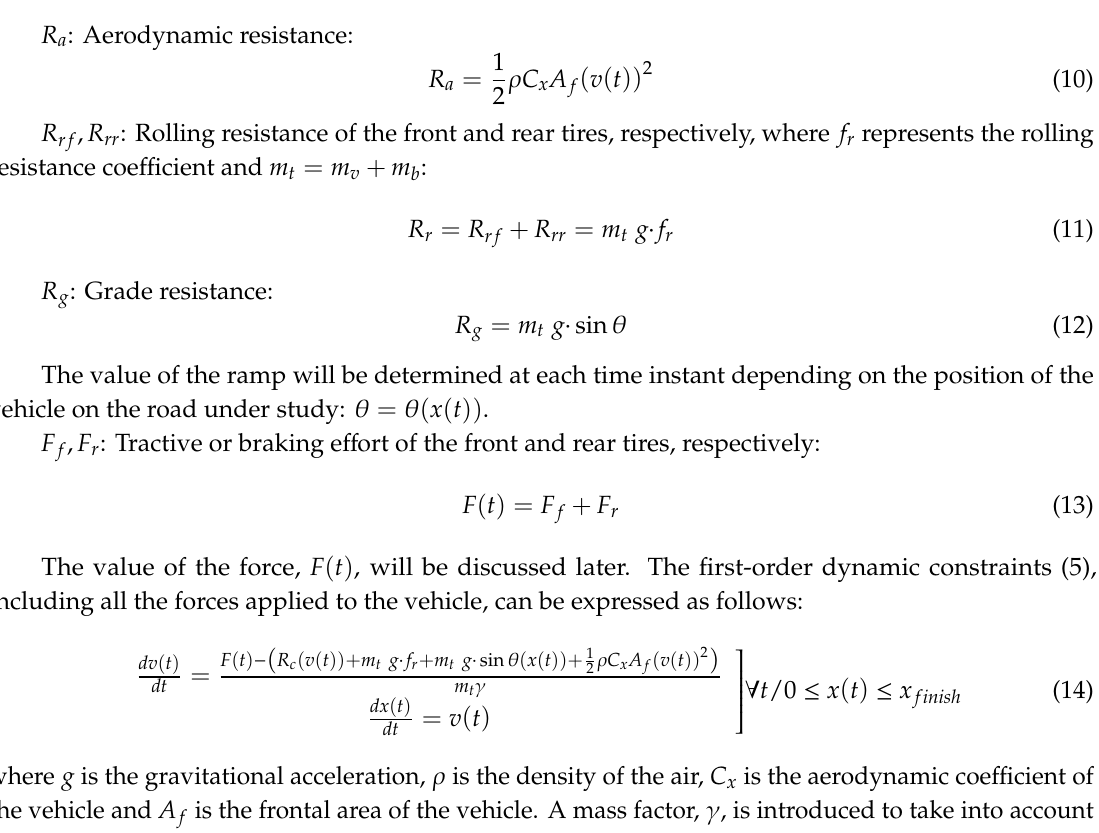
Figure 2. Forces acting on a vehicle.